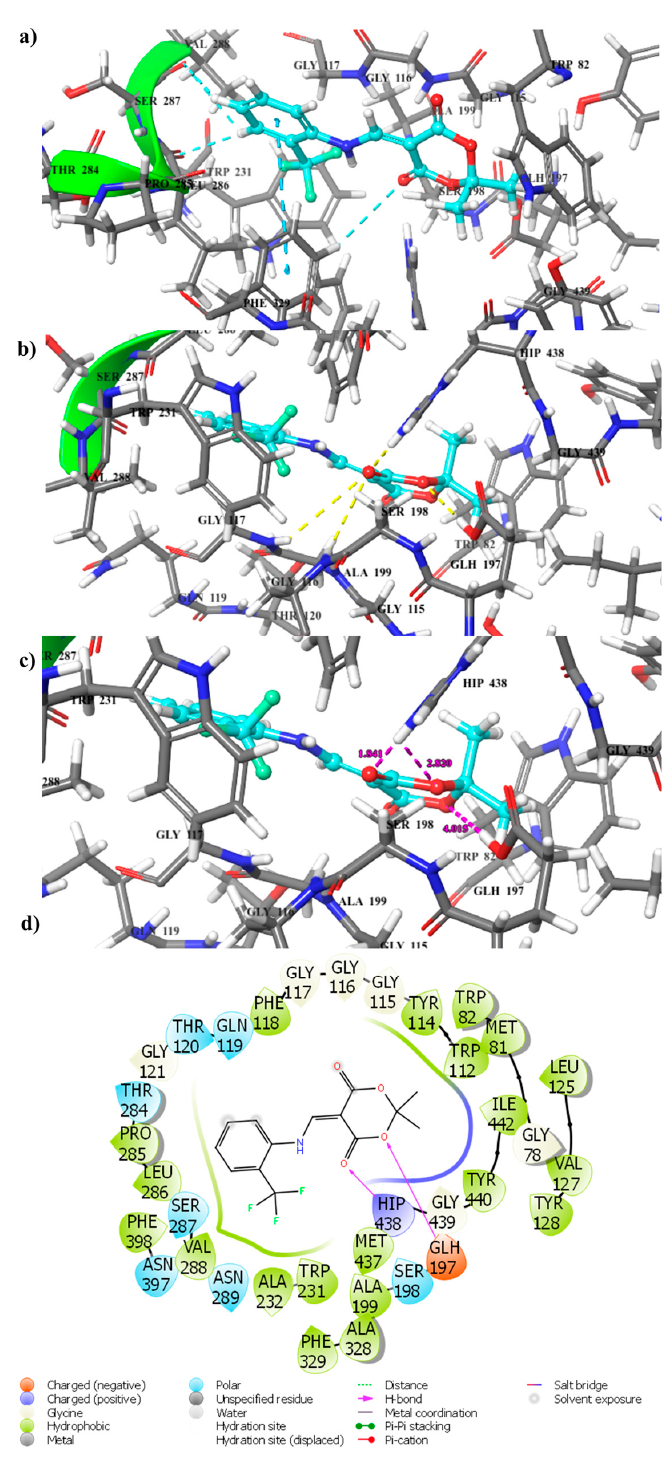
Figure 5. Binding mode of compound 3 inside the active site of BChE. ( a – c ) Docking poses of compound 3 in tri ‐ dimensional space. Ligands are shown in ball and stick mode in elemental and cyan color, and the key residues are shown by stick mode, elemental color, and green color, respectively. ( a ) Aromatic hydrogen bonding and π‐π interaction of ligand atoms with residue atoms is shown in pink colored dashed lines. ( b ) Hydrogen bonding of ligand atoms with residue atoms is shown in pink colored dashed line ( c ) Hydrogen and halogen bonding of ligand atoms with residue atoms is shown in pink colored dashed line ( d ) Docking pose of compound 3 inside the active site in two dimensional space.